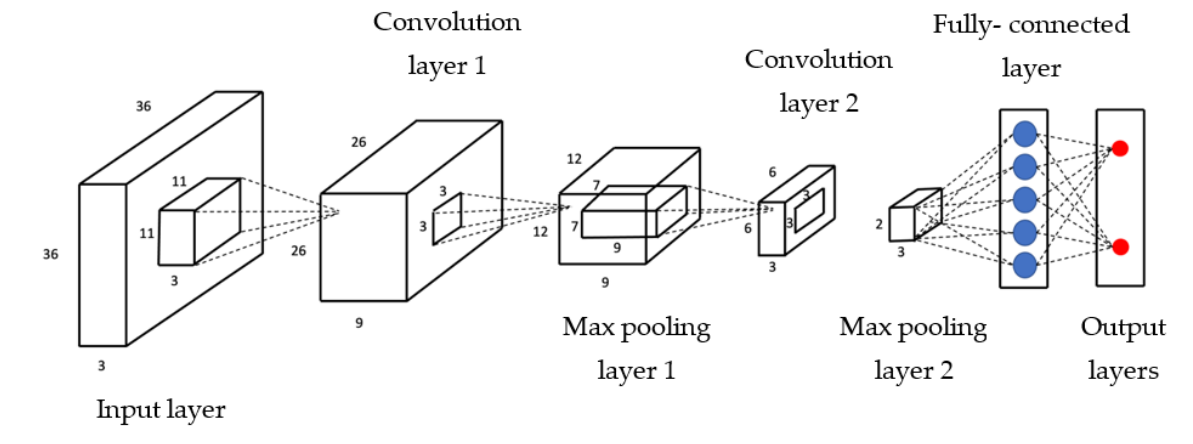
Figure 6 . Illustration of a CNN model [33].